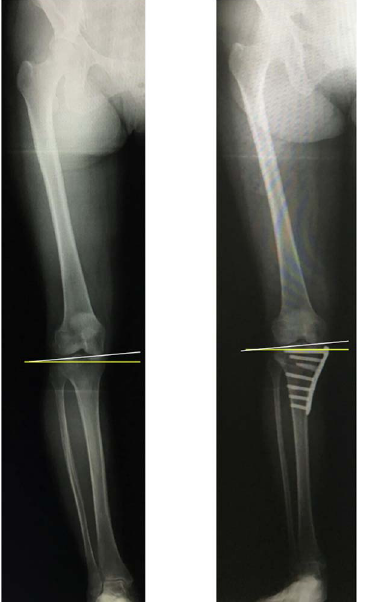
Figure 1. Joint line obliquity. Single-limb standing anteroposterior radiograph of a lower extremity. JLO was de fi ned as the angle between the line parallel to the ground (yellow line) and the articular surface of the proximal tibia (white line). Medial inclination was de fi ned as “ + ” and lateral inclination was de fi ned as “–”